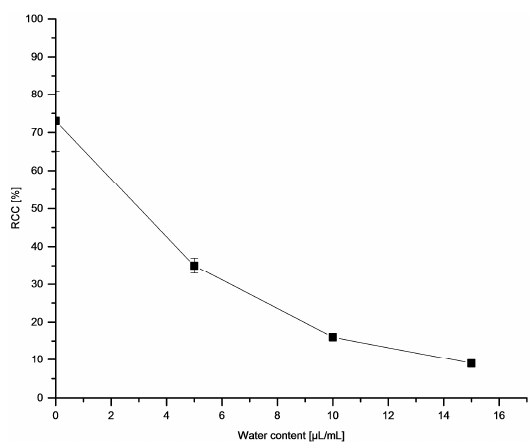
Figure 3. Effect of water on 18 F-fluorodestannylation. Conditions: [ 18 F]Fluoride (~50 MBq) was eluted from a QMA-CO 3 cartridge with a solution of Et 4 NOTf (3.1 mg, 11 µ mol) in n BuOH (300 µ L) (see legend of Table 1). A solution of PhSnMe 3 (14.5 mg, 60 µ mol) and Cu(py) 4 (OTf) 2 (20.3 mg, 30 µ mol) in DMA (700 µ L) containing the respective quantity of H 2 O was added, the reaction mixture was heated at 100 ◦ C for 10 min under air atmosphere, diluted with H 2 O (1 mL) and analyzed by HPLC. All experiments were carried out in